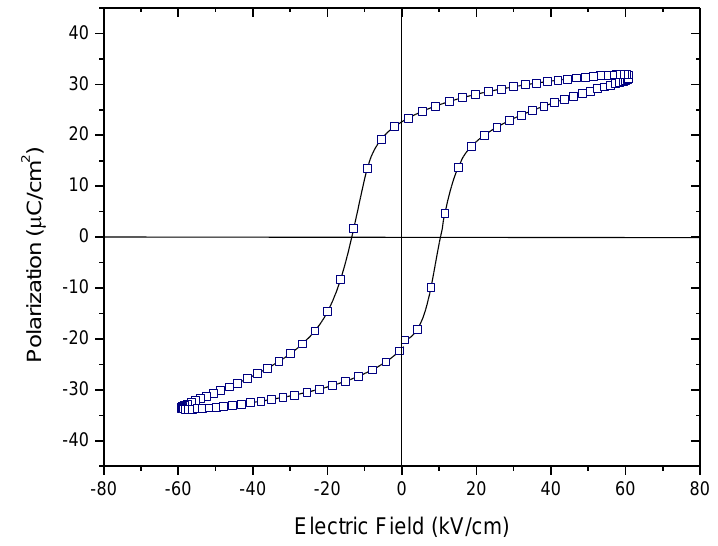
Figure 12. Ferroelectric hysteresis loop of Cu co-fired NKN actuator.